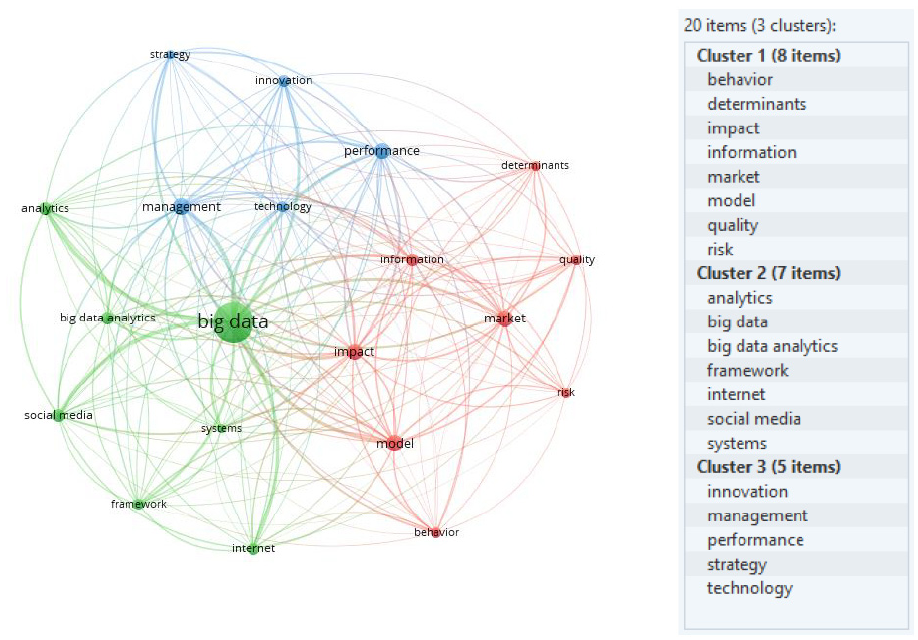
Figure 6. Keyword co ‐ occurrence network.